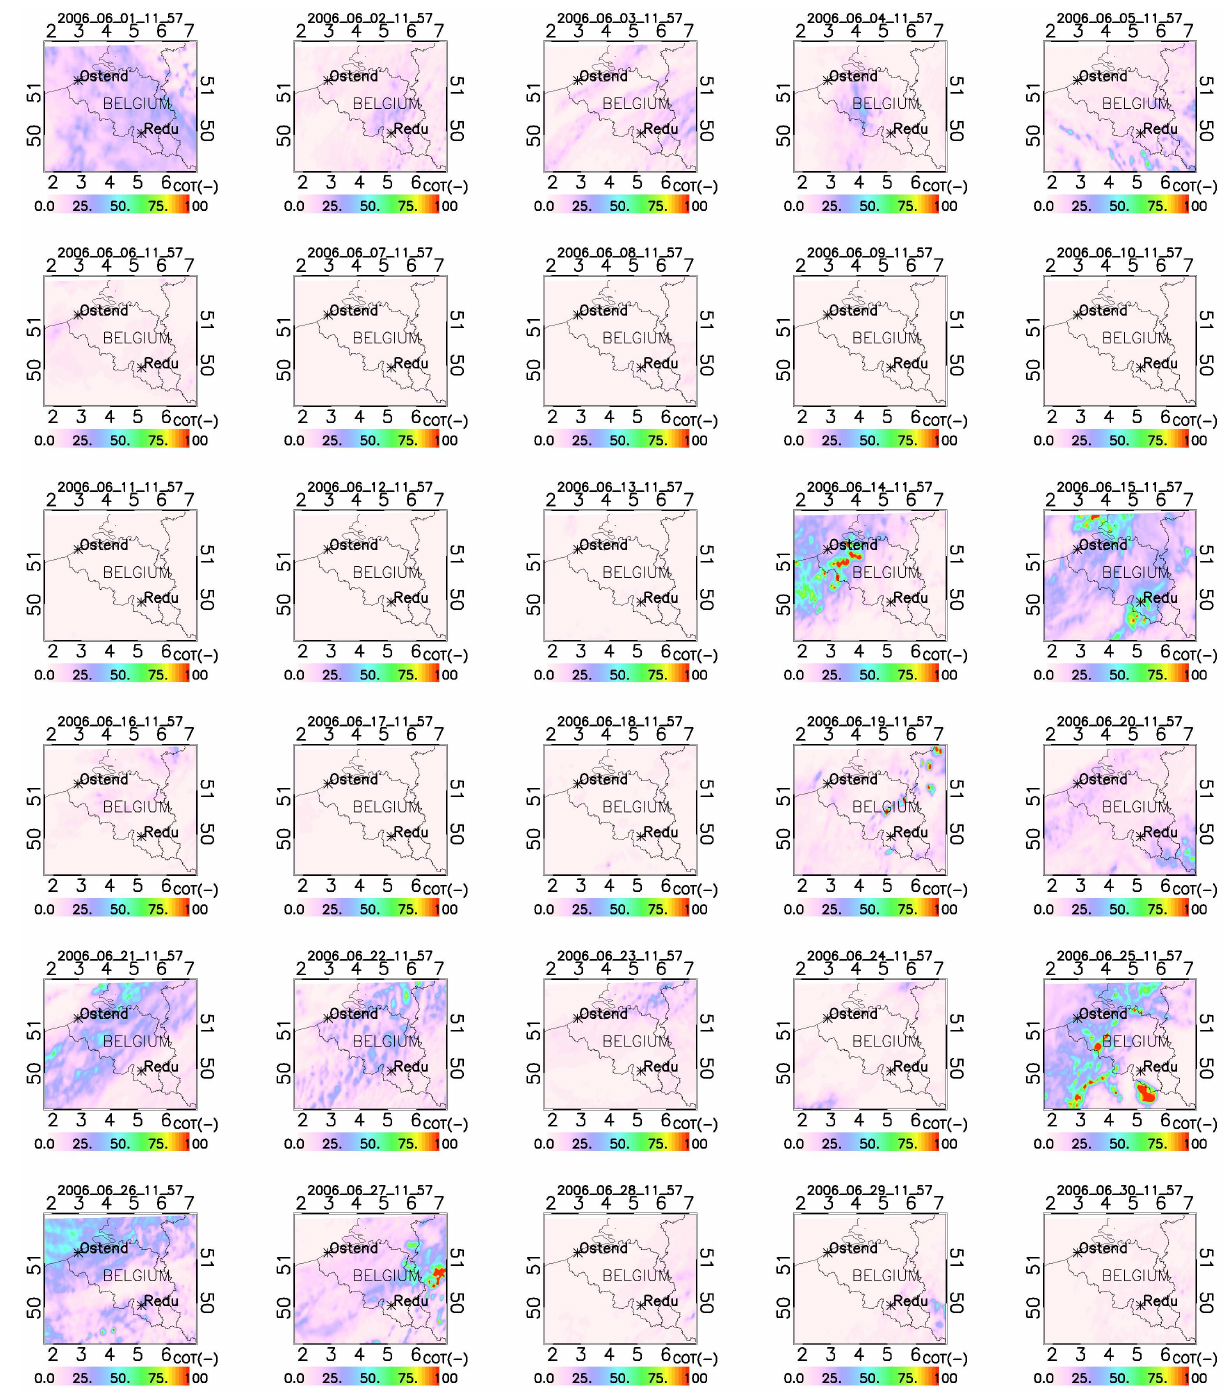
Fig. 5. Location of the measurement sites on a Belgian map with daily noon (11:57 UTC) cloud optical thickness values as retrieved from SEVIRI for the month of June